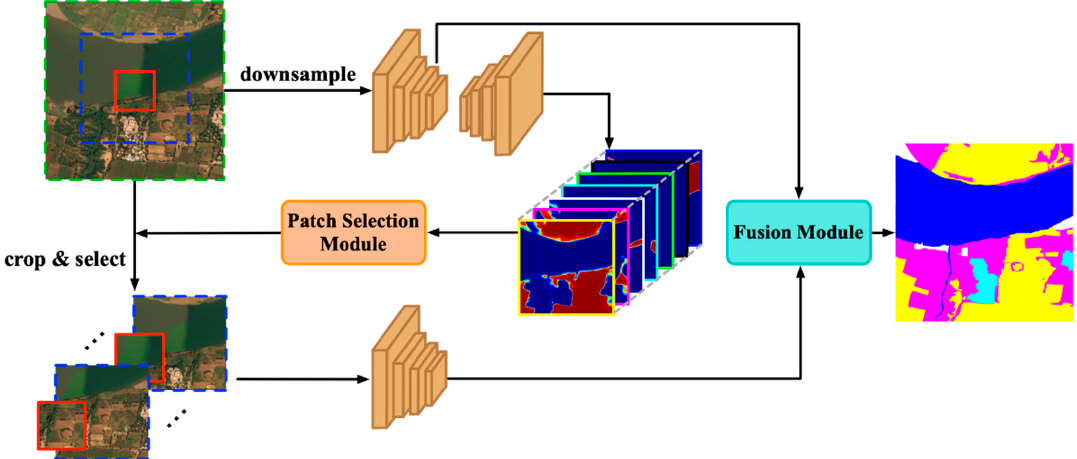
Figure 2. Overview of our proposed MCFNet. The global and local branches are images that have been down-sampled and cropped respectively. PSM module is used to identify poorly segmented local patches within the global segmentation, and FM module performs segmentation enhancement on those poorly segmented local patches. The final segmentation is created by aggregating the global and local branch feature maps .